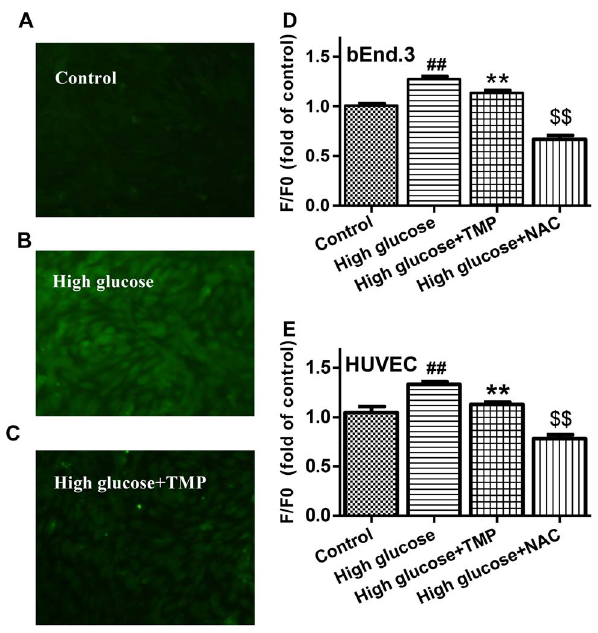
Figure 3. TMP decreased ROS generation in high glucose- treated endothelial cells. CM-H 2 DCFDA indicator was used to detect ROS levels in HUVEC treated with ( A ) 5.6 mmol/L glucose (Control), ( B ) High glucose (30 mmol/L) and ( C ) High glucose + TMP (30 m mol/L). ( D ) bEnd.3 and ( E ) HUVEC were treated as indicated for 48 hrs, and ROS production was measured using flexstation3 and quantified with the changes in fluorescence intensity. ‘‘F0’’ represents fluorescence of Control group and ‘‘F’’ depicts fluorescence of other treated groups. Data are mean 6 SEM (n=4). # P , 0.05 vs. Control; ## P , 0.01 vs. Control; ** P , 0.01 and $$ P , 0.01 vs. High glucose.